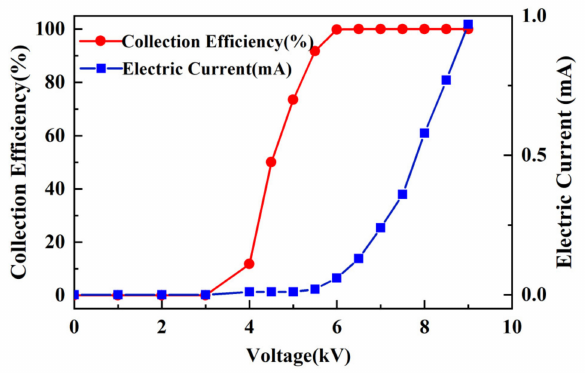
Figure 10. The performance curve of the electrostatic